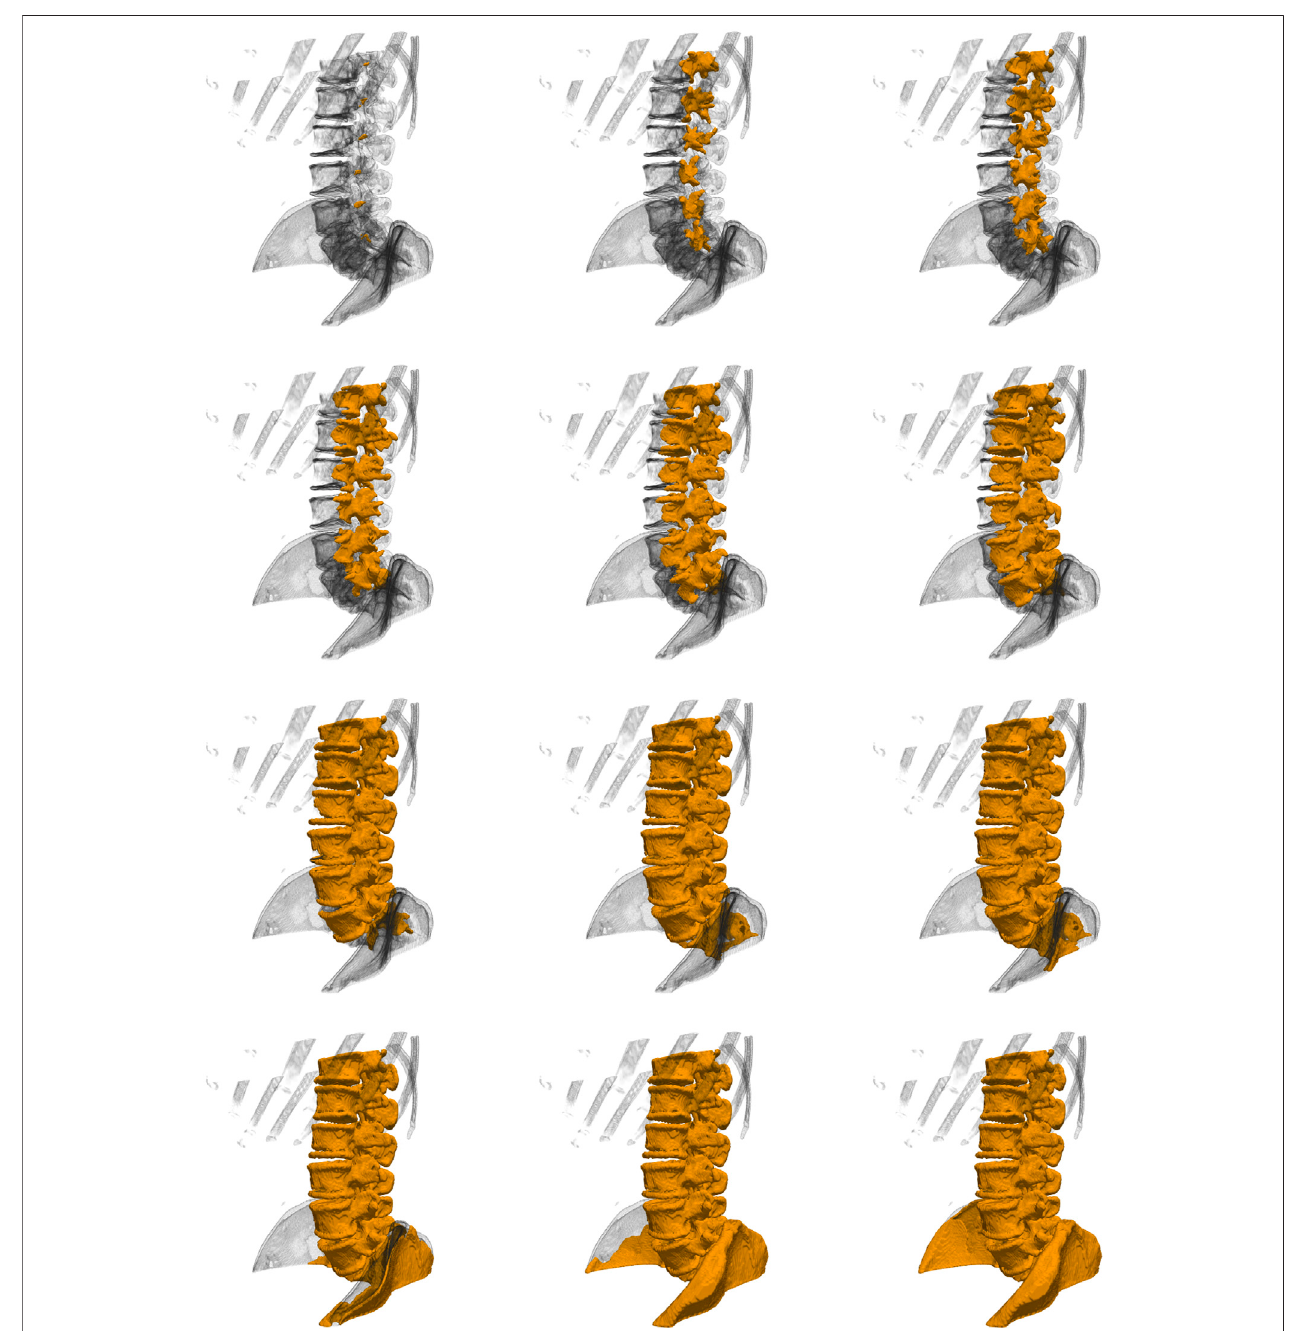
FIGURE 2 | ( Left to right and top to bottom ) The surface segmentation process for Database 1, using the region based fl ow on the fl ux-map, as explained in Section 3.2 . Samples of the entire evolution are shown, from initialization to the fi nal extracted surface. Here we initialize the fl ow with multiple seeds to illustrate their simultaneous evolution. In our experiments using Pipeline 1 we typically used two or three seeds placed within the vertebral surface, in the middle of the FoV. Note: The adjoining sacrum and hips are manually removed using the methods in Yushkevich et al. (2006). In the text we explain how the subjects with larger holes on the extracted surface are